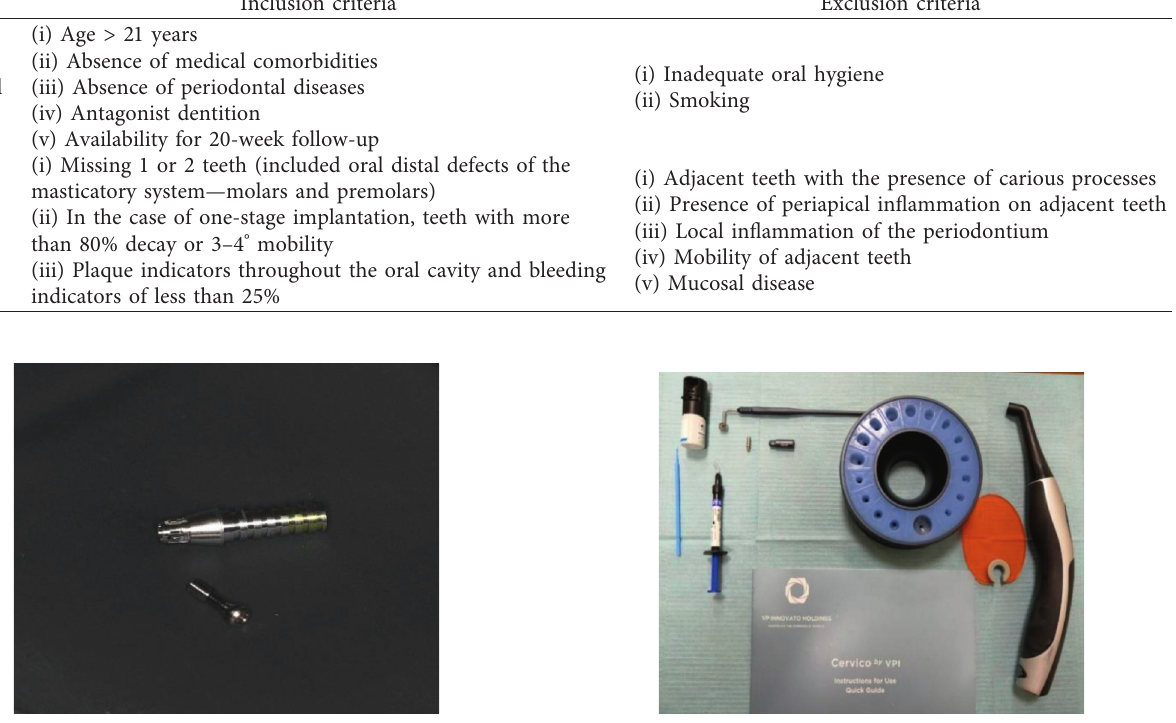
Figure 2: Prefabricated provisional abutment. Figure 3: Cervico